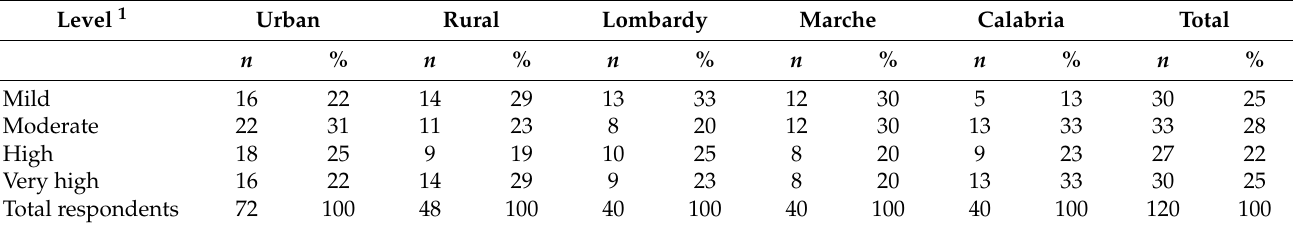
Table 4. Level of physical/functional limitations, by sites and